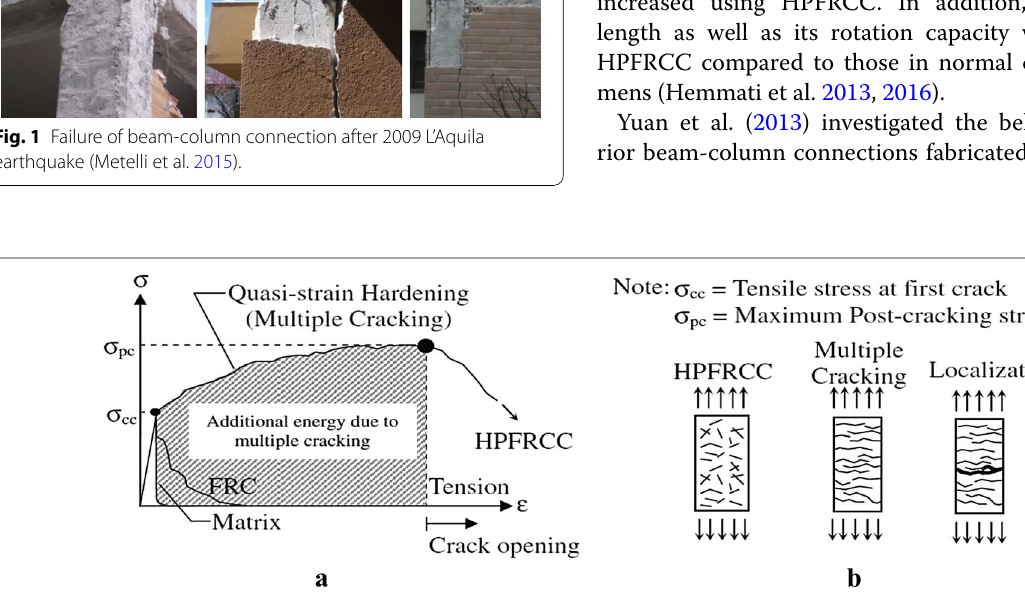
Fig. 2 A comparison between the tensile behavior of normal concrete, FRC and HPFRCC: a comparison between the stress–strain response of HPFRCC and FRC in tension; b multiple cracks and localization (Naaman